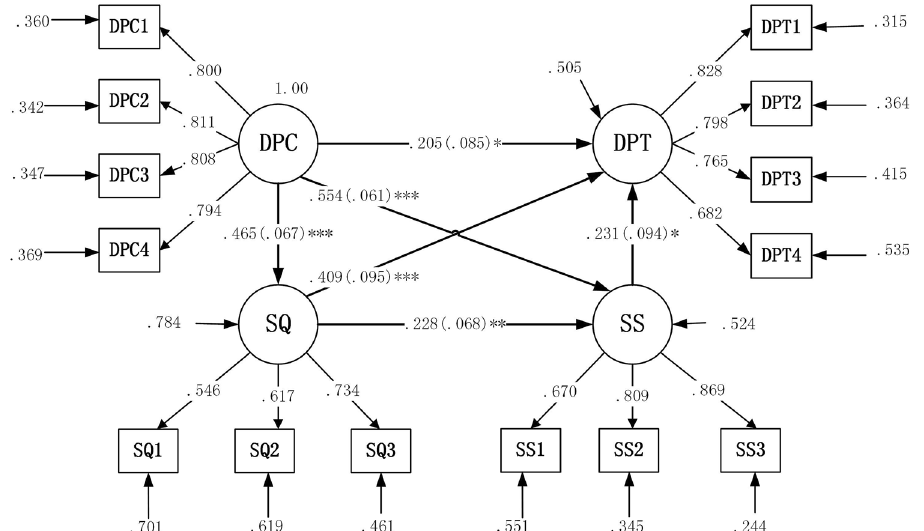
Figure 2. The pathway analysis of the factors influencing doctor–patient trust. The values in the brackets represent the standard error. * P < 0.05, ** P < 0.01, and *** P < 0.001. DPC doctor–patient communication, SQ service quality, SS service satisfaction, DPT doctor–patient trust. Fitting of model: Chi-square test of the model fit = 210.535; degrees of freedom = 71; RMSEA = 0.059; CFI = 0.962; TLI = 0.952; SRMR =